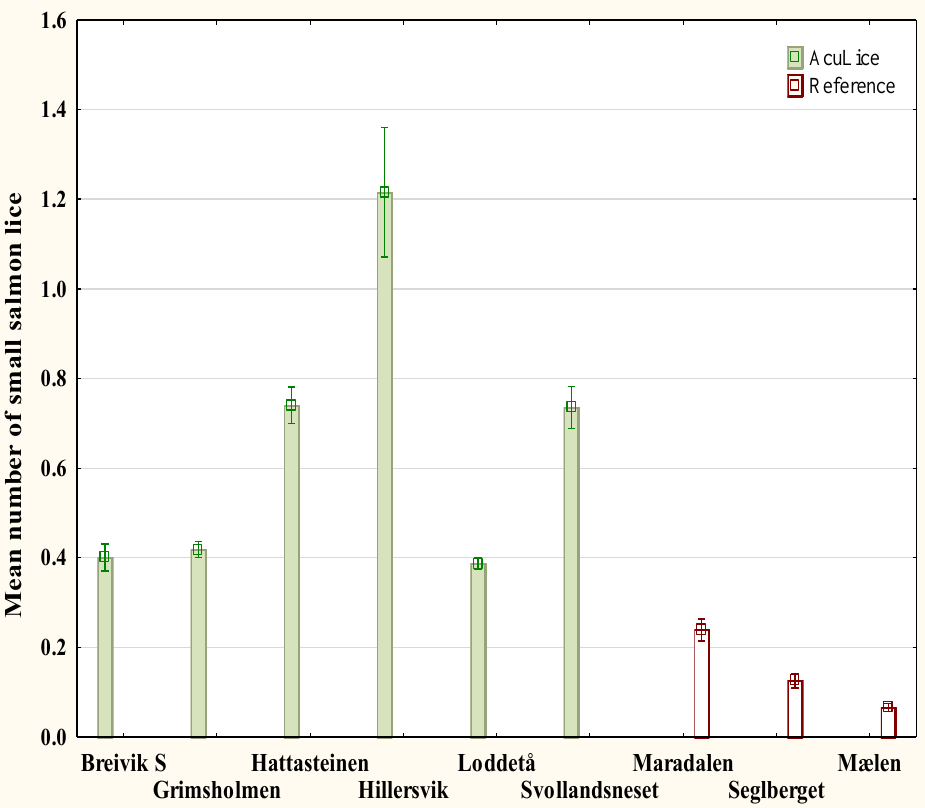
Figure 5. Mean number of small (sessile and mobile) salmon lice measured per Atlantic salmon in the period from mid-summer 2019 to late-spring 2020 at each facility. Groups of Atlantic salmon exposed to AcuLice treatment (AcuLice) compared to the reference group (reference). Green-marked columns are facilities with AcuLice treatment and red columns are the reference facilities. Data from each facility is presented as mean ± SEM (N =